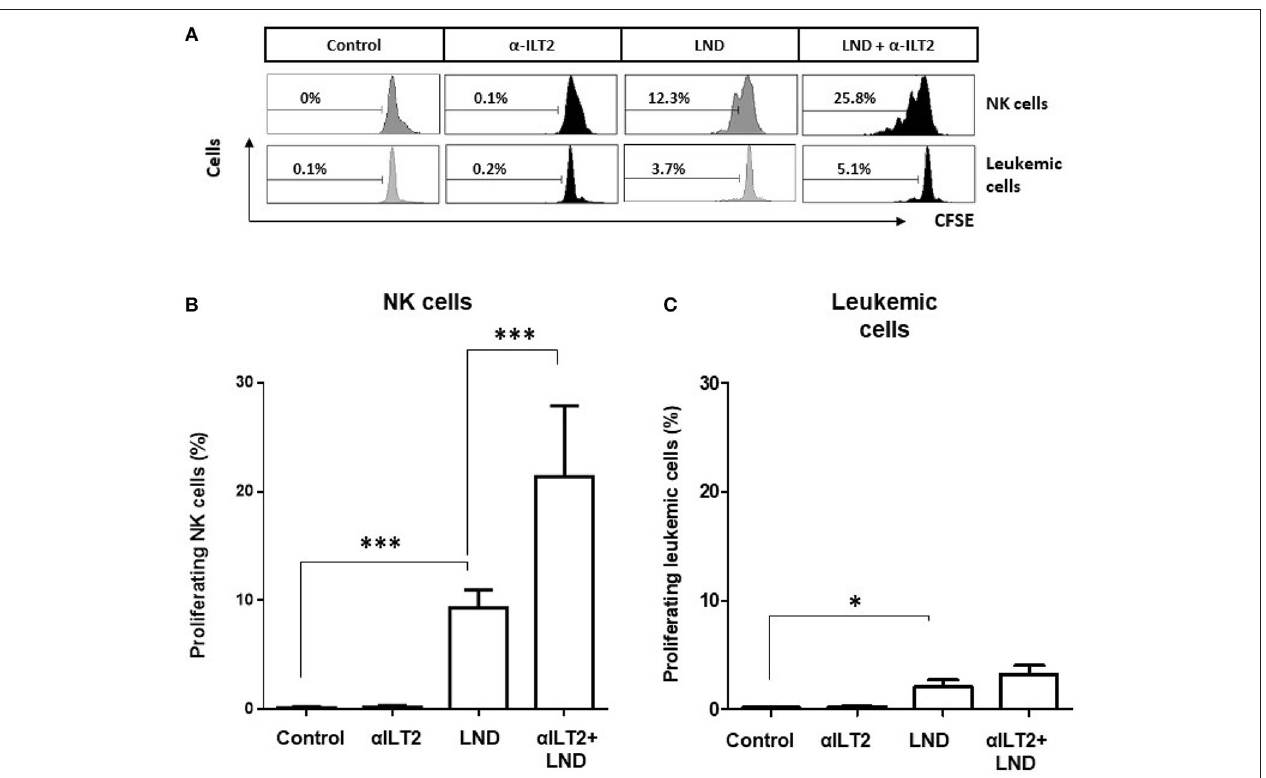
FIGURE 6 | ILT2 blockade and lenalidomide promote NK cell proliferation in CLL. PBMCs from 11 CLL patients were stained with CFSE and cultured in the presence of anti-ILT2 blocking antibody (10 µ g/ml) or irrelevant IgG 1 and lenalidomide (LND, 1 µ M) for 14 days. The proliferation of NK cells and leukemic cells was analyzed by evaluating the expression of CSFE by flow cytometry. (A) Histograms show the flow cytometry profiles corresponding to CFSE expression on NK cells (CD3 − CD56 + ) and leukemic cells (CD19 + cells) of a representative CLL patient. (B,C) The histograms show the comparison of the percentage of proliferating NK cells (B) and leukemic cells (C) among the different experimental conditions analyzed. Bars represent the mean ± SEM from samples analyzed. SEM, Standard Error of the Mean; Wilcoxon Matched-Pairs Signed Ranks test; * P < 0.05, *** P <